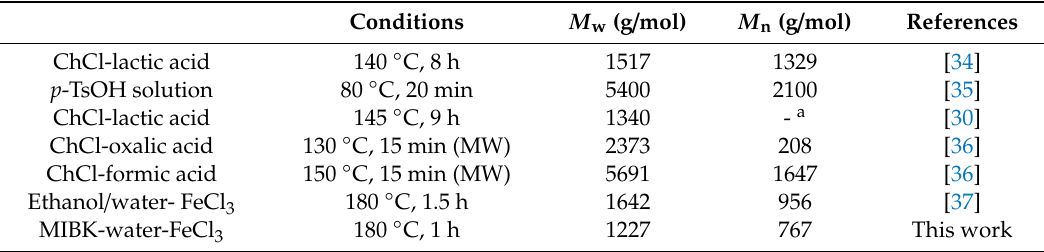
Table 2. The molecular weights of extracted lignin reported in the